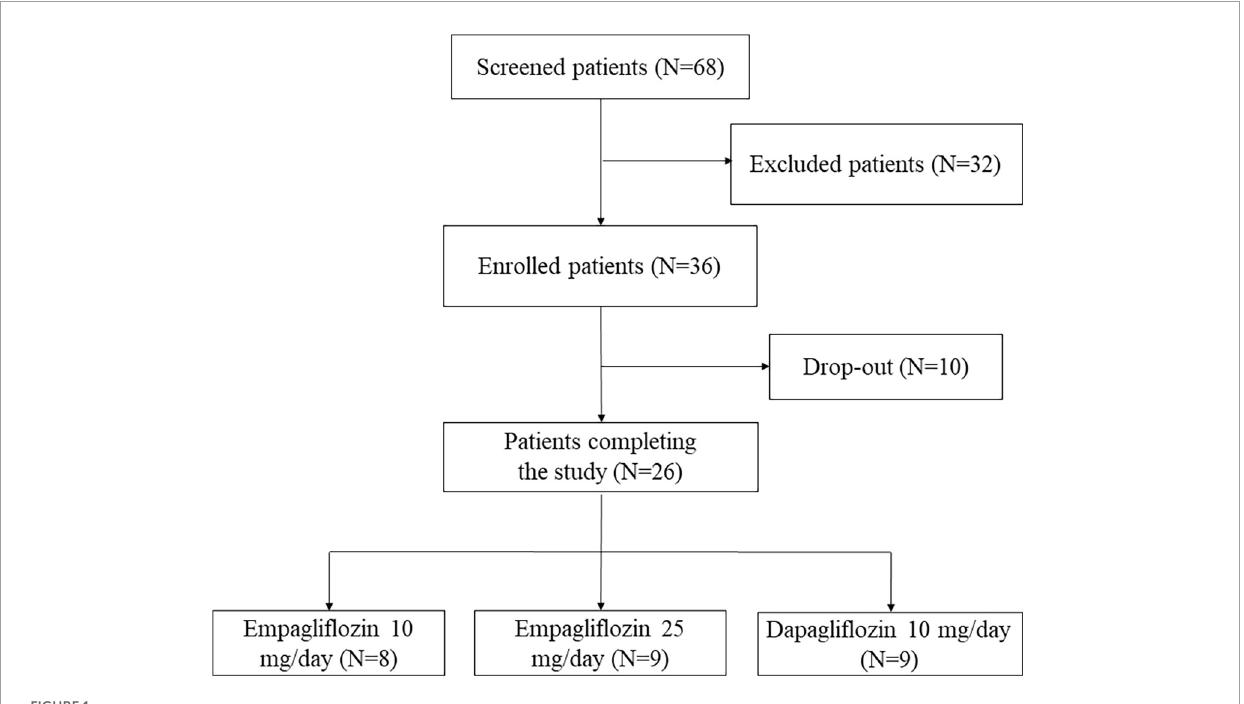
FIGURE1 Recruitment process